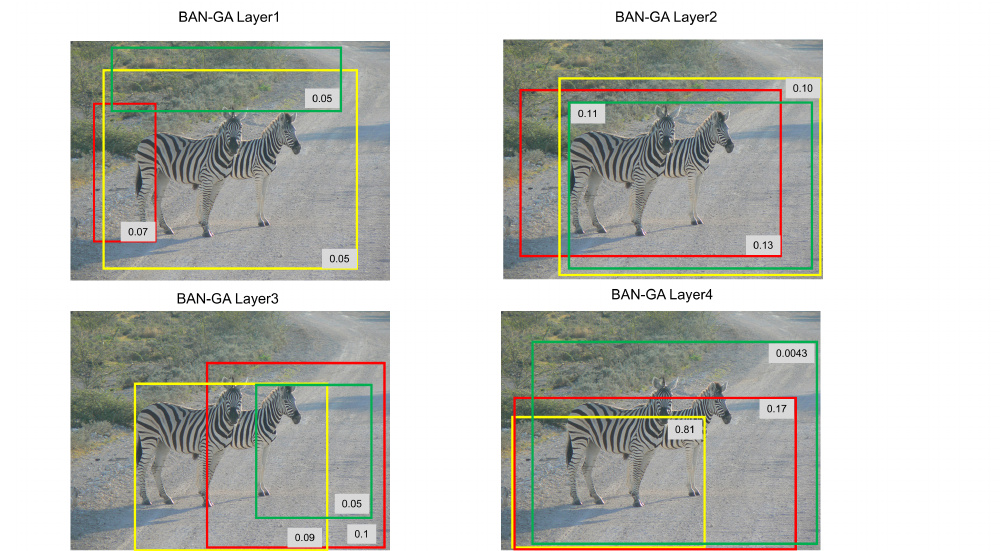
Figure 9. We set the number of layers of the model to 4. Visualizations of the top three image regions with the largest weight, marked the corresponding regions with boxes, and the numbers on the boxes represent the weight of the corresponding image regions in each layer. With the increase of the number of layers, the weight of the top two regions increases